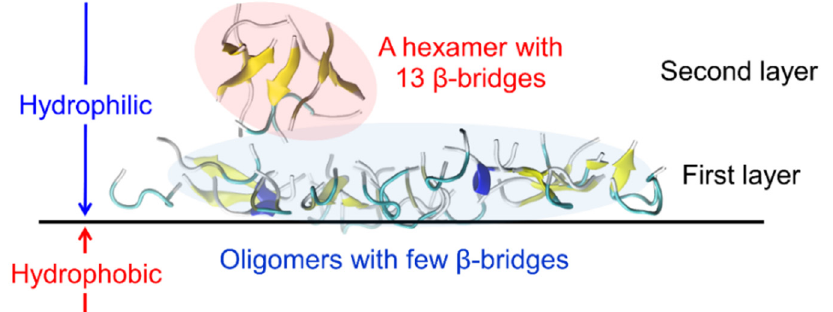
Figure 3. Snapshot of oligomers that had a few β -bridges in the first layer and a hexamer with 13 β -bridges in the second layer. Reprinted with permission from Reference [45]. Copyright 2020 American Institute of Physics.